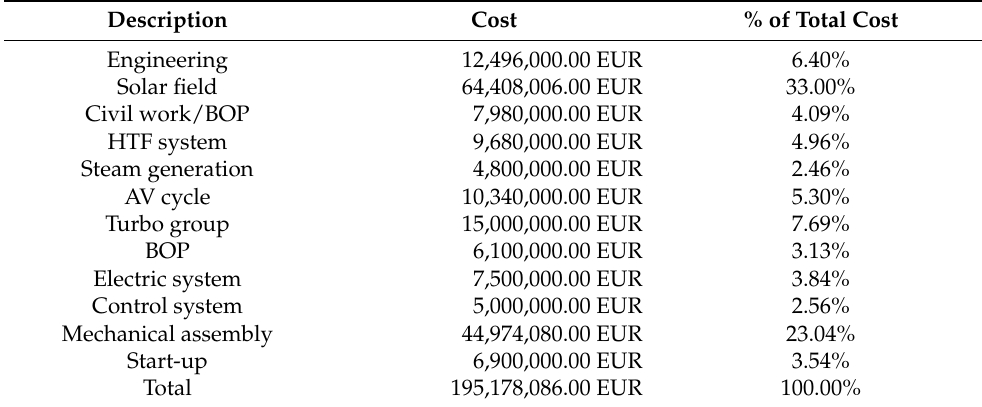
Table 5. Construction cost for a 50-MW CSP in 2016 (trough collector technology)